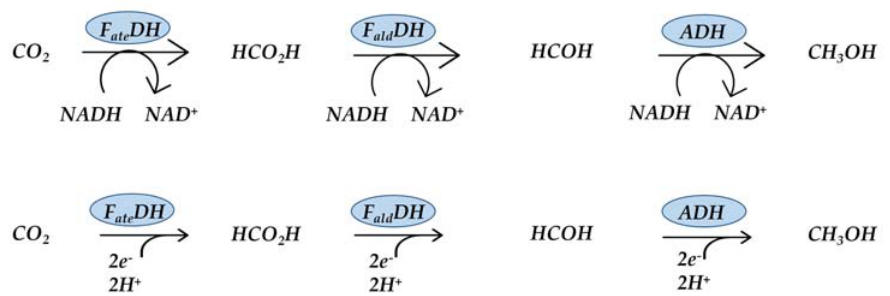
Figure 8. Reaction of CO 2 reduction to methanol with and without cofactor [51].